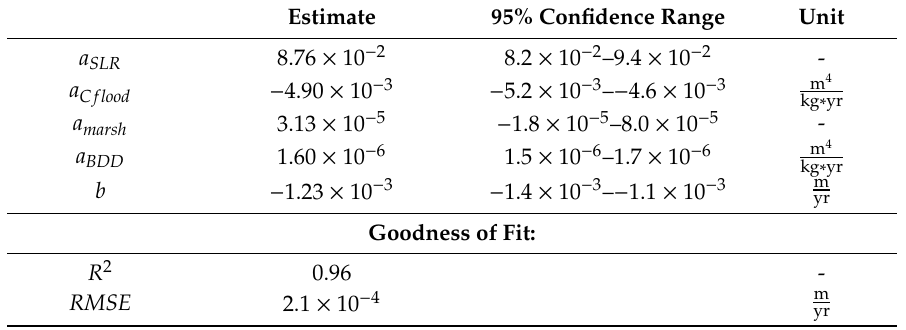
Table 3. Fitted parameters of the linear model of Equation (2). See text for meaning of